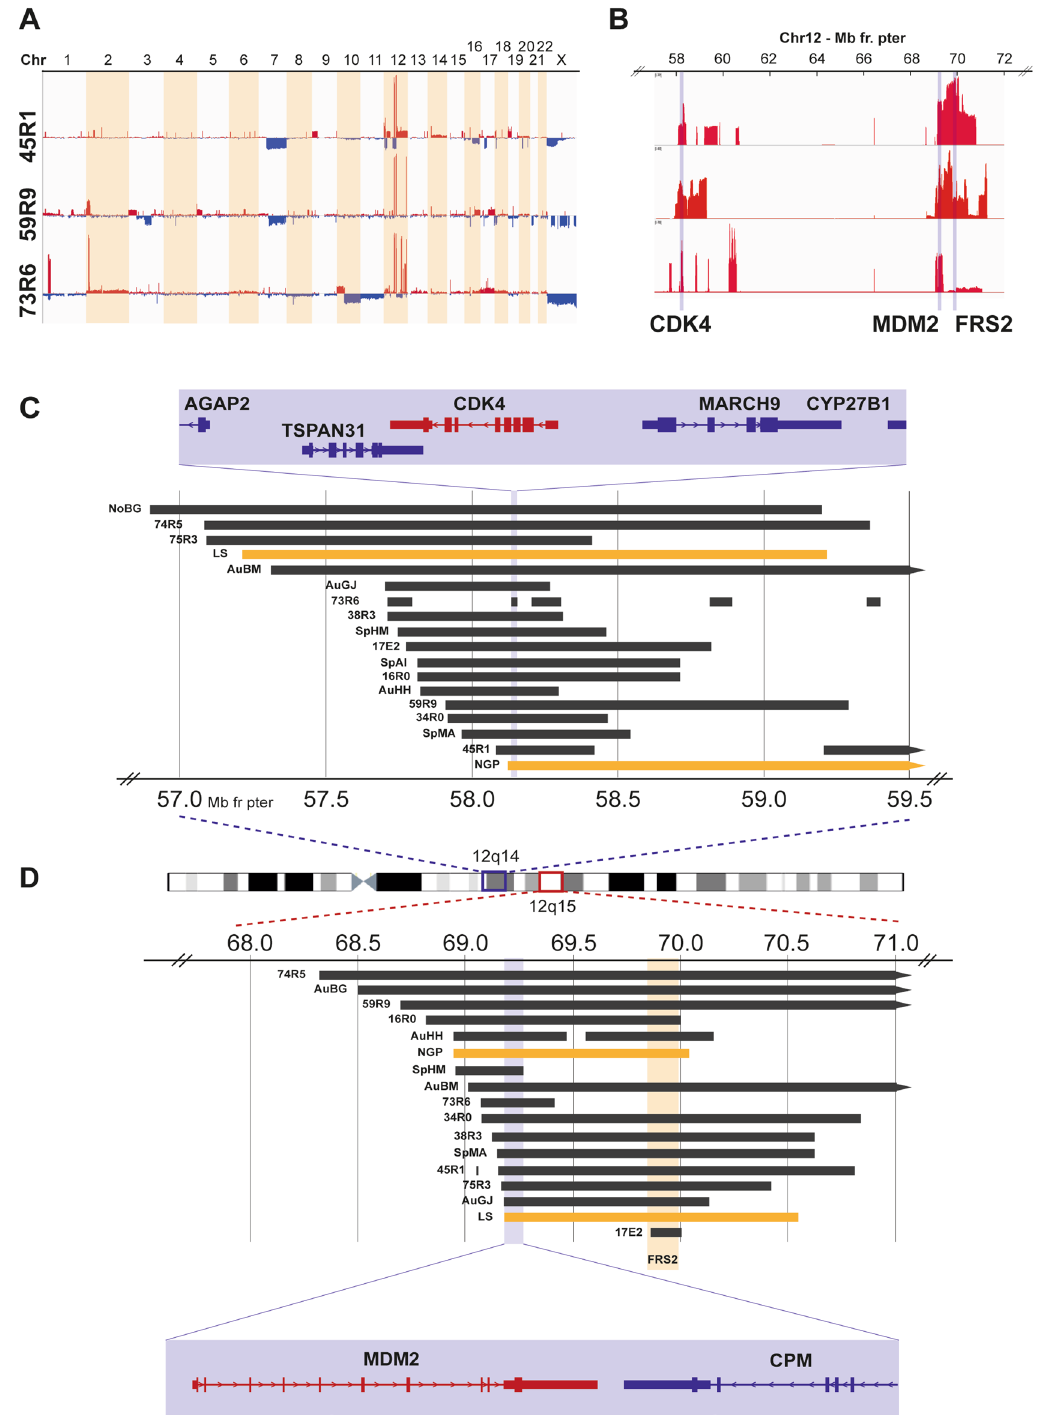
Figure 1. Genomic findings regarding the tumors with 12q amplification. ( A ) Whole-genome copy number profiles generated from WGS for three NB tumors with 12q amplification and ( B ) copy number profiles for chromosome 12, 57–72 Mb from the p-terminal with corresponding amplification peaks. ( C ) Amplified regions at 12q14 in relation to genomic position and genes with the shortest region of overlap (SRO), indicated in blue, based on amplicon boundaries of all primary tumors and cell lines analyzed. ( D ) Amplified regions at 12q15 in relation to genomic position and genes with the SRO indicated in